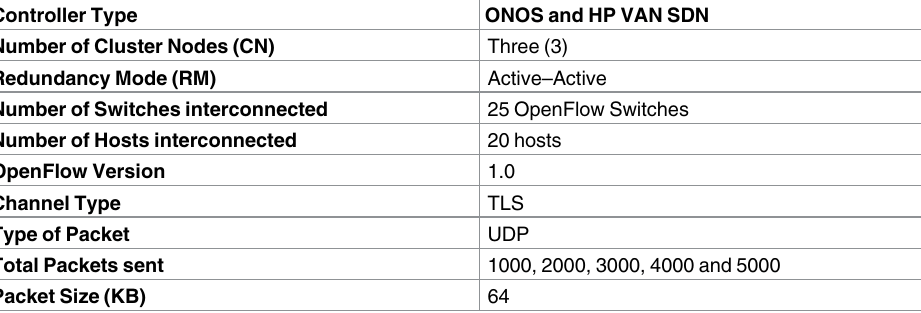
Table 4. Packet loss controller